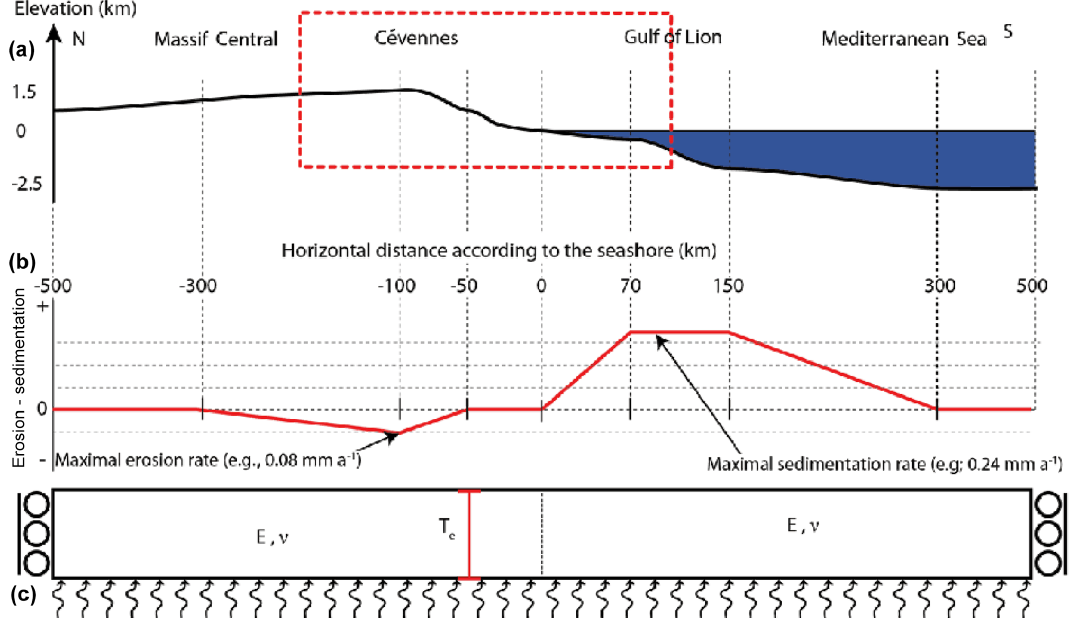
Figure 11. (a) Schematic topographic profile. The red box delimits the area shown Figs. 1 and 9. (b) Surface processes profile; negative values are for erosion, and positive values are for sedimentation. (c) Model setup with two compartments (one for the Cévennes area and the second one for the Gulf of Lion). The base of the model is compensated in pressure, and the right and left limits are fixed at zero horizontal velocity and free vertical velocity. T e is the equivalent elastic thickness (in kilometers), E (in pascals) and v are the Young’s modulus and the Poisson coefficient, respectively, whose values are independent in each